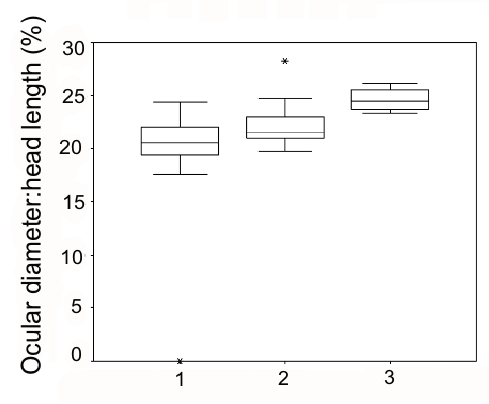
Fig. 3. Ocular diameter:head length proportions, standard deviations and confidence intervals for Eigenmannia vicentespelaea (n = 25) and Eigenmannia sp. (n = 15) from São Domingos karst area, Central Brazil. *outliers; 1, E. vicentespelaea ; 2, Eigenmannia sp. collected in epigean river; 3, Eigenmannia sp. collected in subterranean stream reaches; horizontal bars,